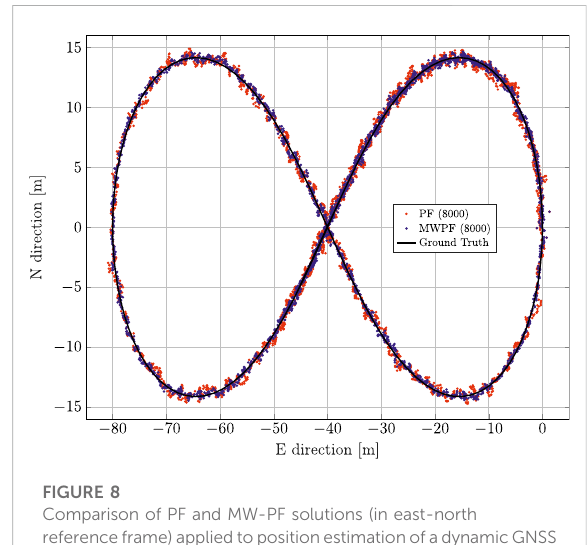
FIGURE 7 Comparison of the CDF of the positioning error of a static receiver using PF and MW-PF solutions with different numbers of particles.